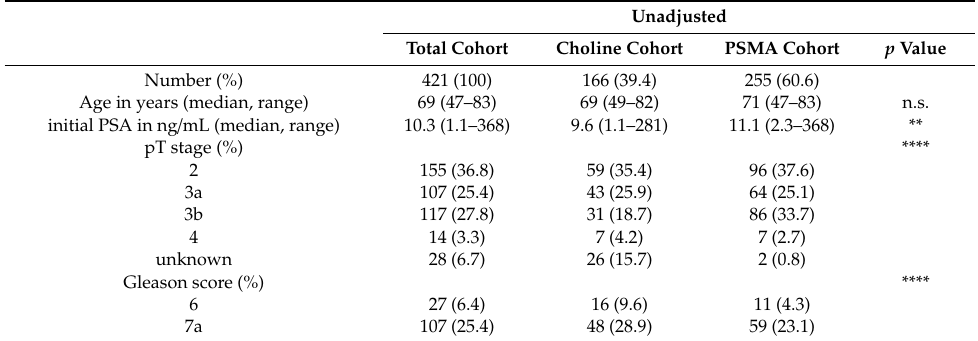
Table 1. Patient